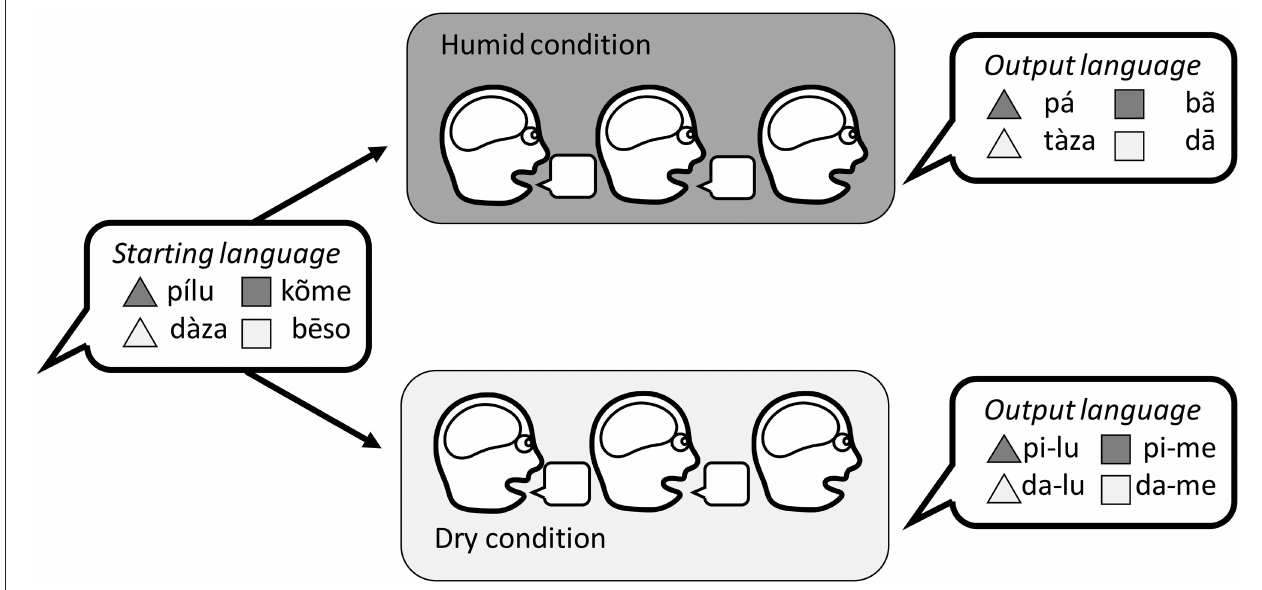
FIGURE 7 | A hypothetical iterated learning experiment to investigate the link between humidity, desiccation, production, and the loss of tone distinctions. The desiccation hypothesis predicts that languages transmitted in a humid condition would develop a (possibly compositional) system that preserved distinctions in tone, while languages in a dry condition would develop a compositional system that relied on non-tonal distinctions.